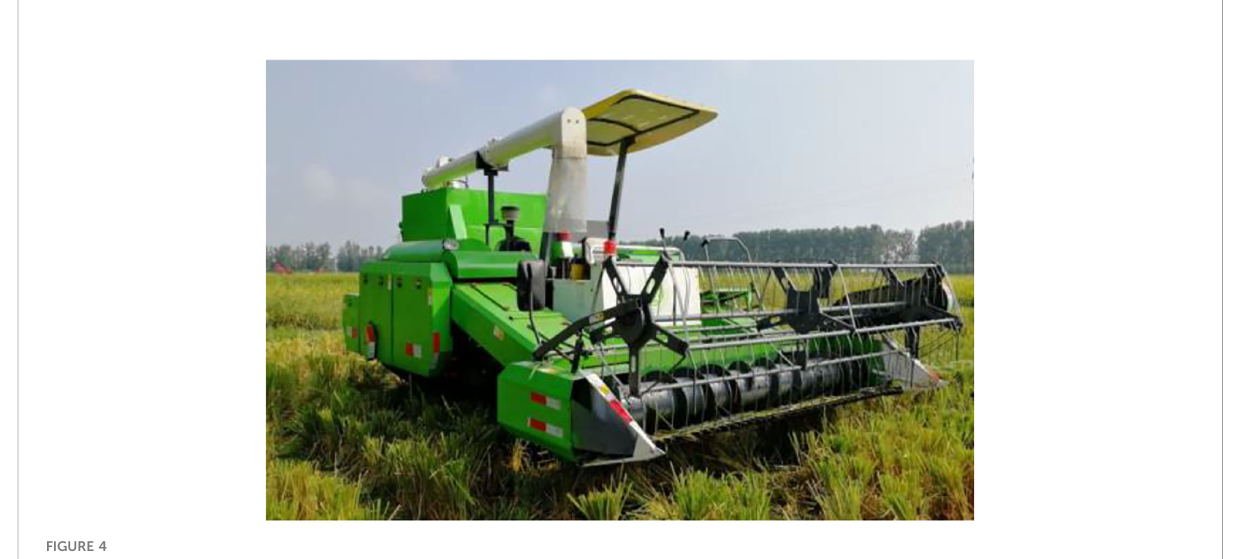
FIGURE 4 Dual-channel rice fi rst-season harvester.